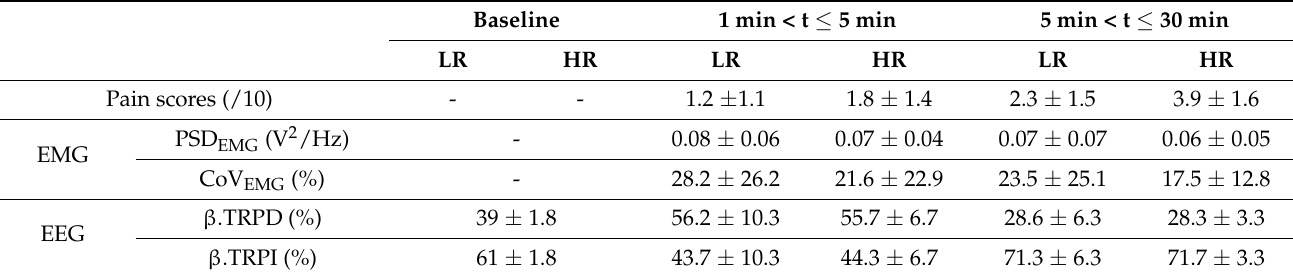
Table 2. Effect of time on pain and neurophysiological variables for high risk (HR) and Low Risk (LR) conditions.